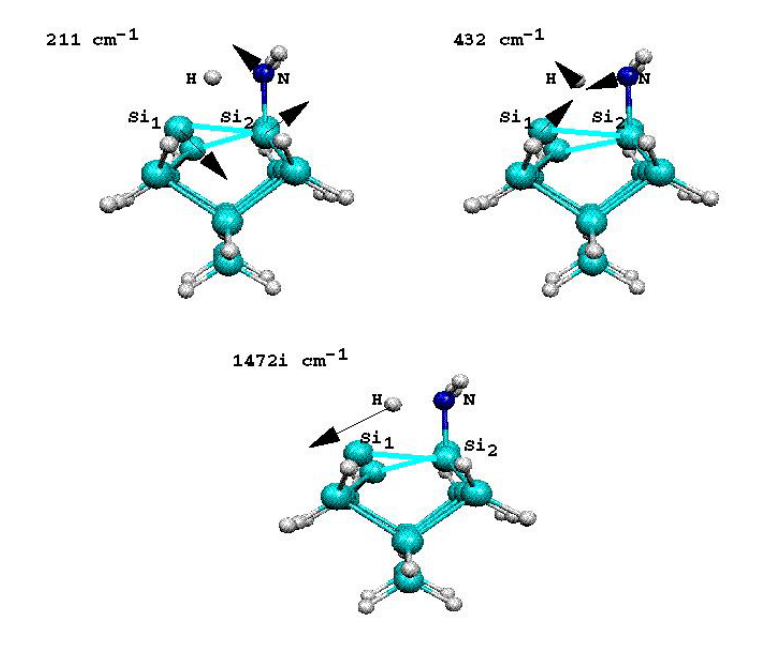
Figure 3. Normal modes most important for the hydrogen transfer within a silicon dimer. 211 cm -1 – the most active hindering mode, 432 cm -1 – the most active helping mode, 1472i cm -1 – the reaction